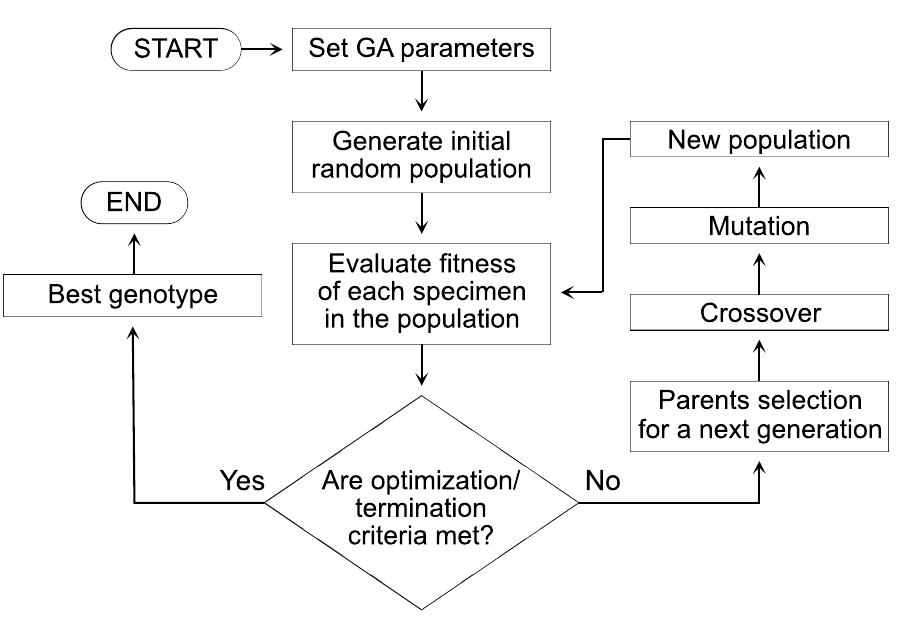
Figure 3. The block schema of the genetic algorithm